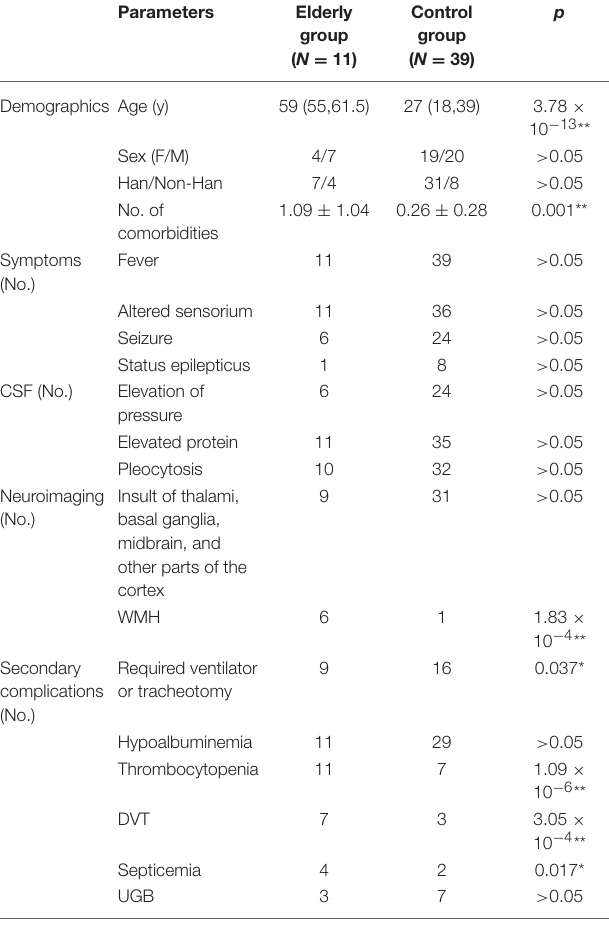
TABLE 1 | Demographic and clinical features of the two groups with JE.